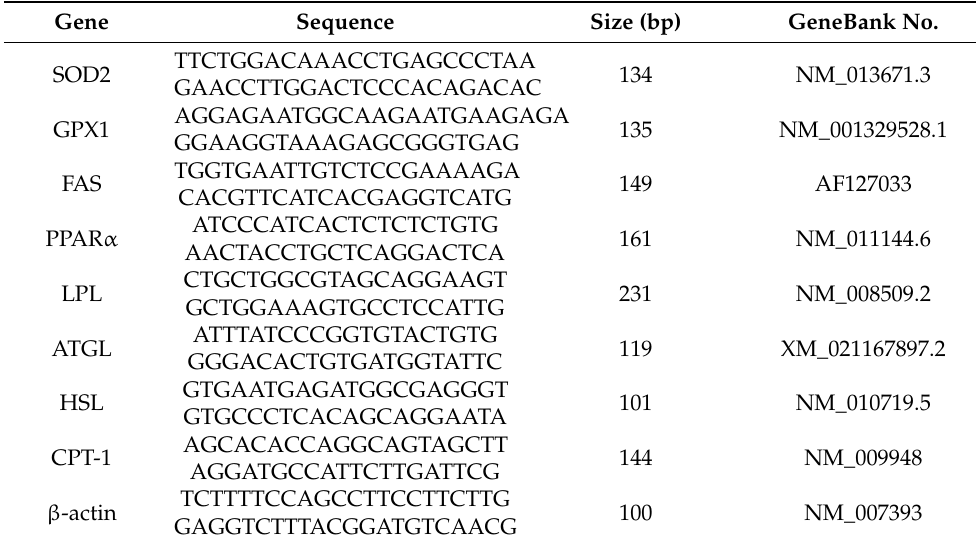
Table 2. Primers used for real-time